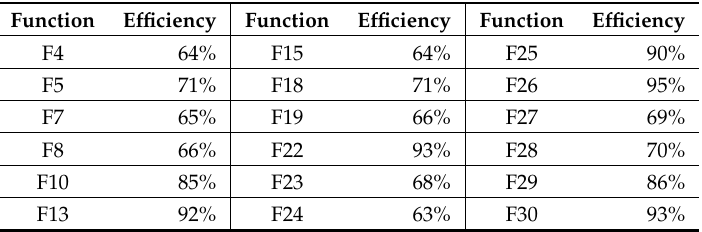
Table 6. Efficiencies for hybrid MPI/OpenMP parallel algorithm, Runs = 30, Population size = 240, Iterations = 10,000, NoP = 15, NoT = 2, NoTP =